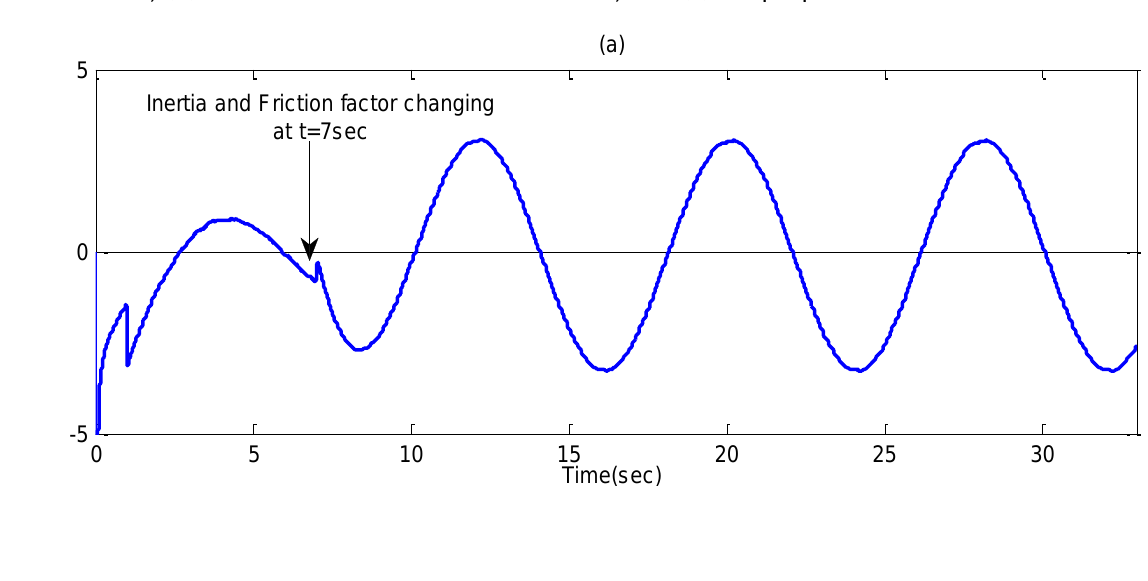
Figure 13. Simulated tracking error responses-based IM drive in Case-3 ; ( a ) the tuned PI controller, ( b ) the conventional BLFC controller, and ( c ) the proposed NBLFC